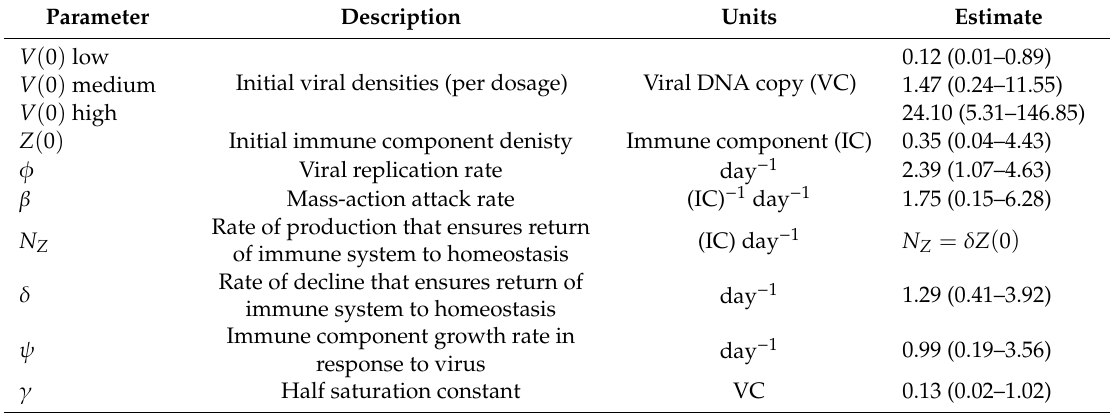
Table 2. Parameter estimates (median and 95% credible intervals) from the most parsimonious model,